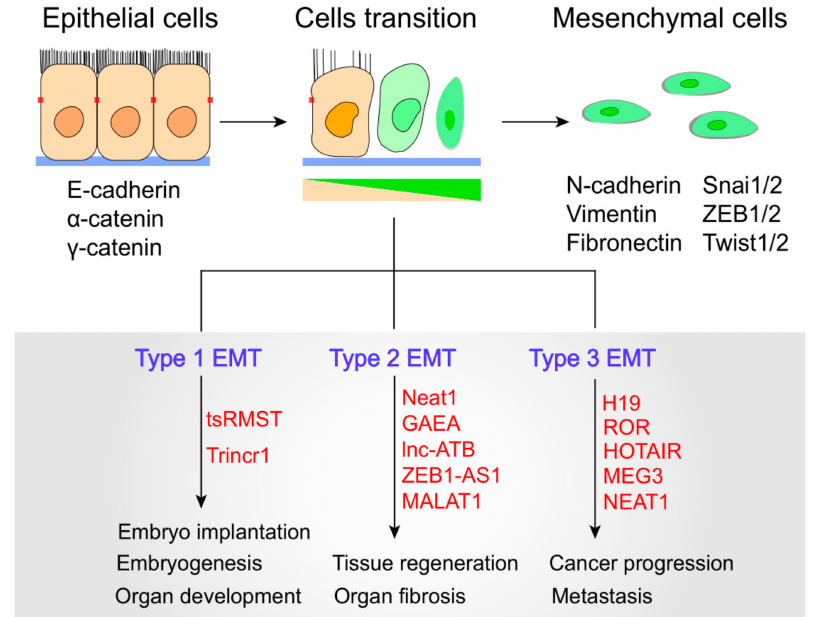
Figure 2. LncRNAs modulate three Epithelial-mesenchymal transition (EMT) subtypes. EMTs involve the functional transition of polarized epithelial cells into mobile and secretory mesenchymal cells. Cells transition indicates progressive loss of epithelial markers and gain of mesenchymal markers. Epithelial and mesenchymal cell markers and related lncRNAs are